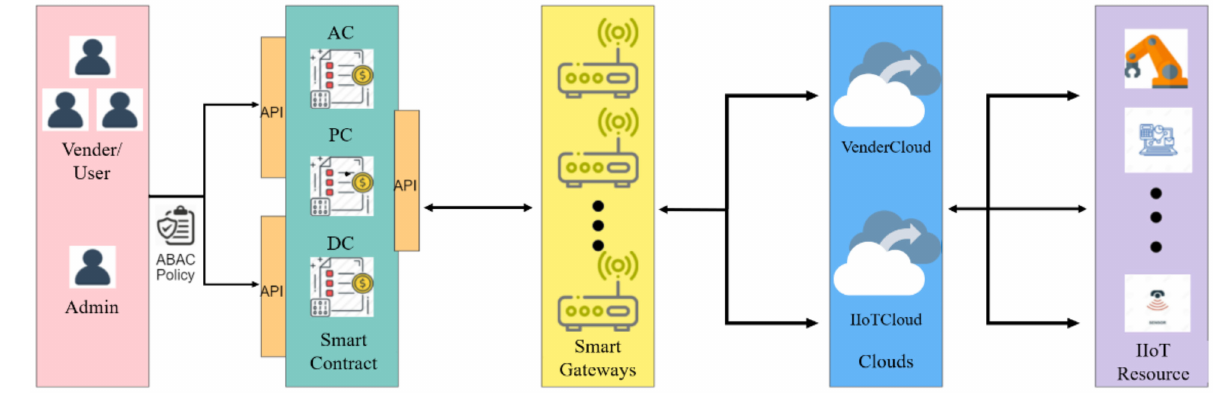
Figure 4. System